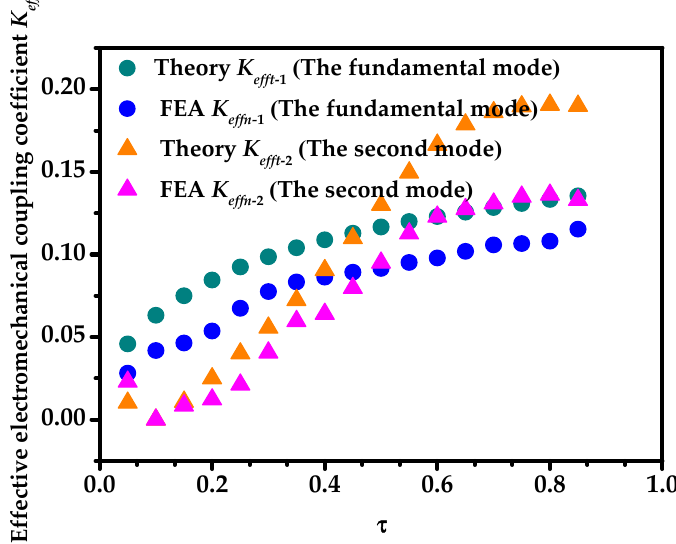
Figure 7. The relationships between the effective electromechanical coupling coefficients and τ at the fundamental mode and the second mode.